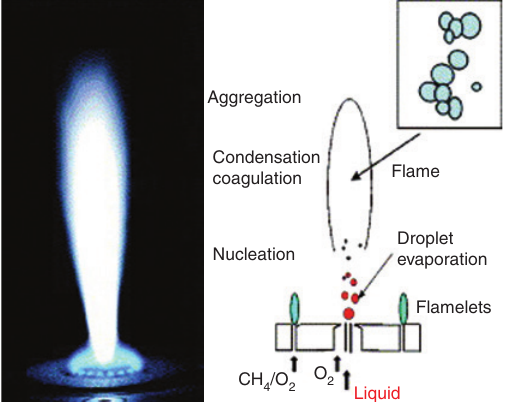
Figure 4: Flame spray pyrolysis and schematic of nanophotocata- lyst formation. Reprinted with permission from Ref. [33]. Copyright 2002